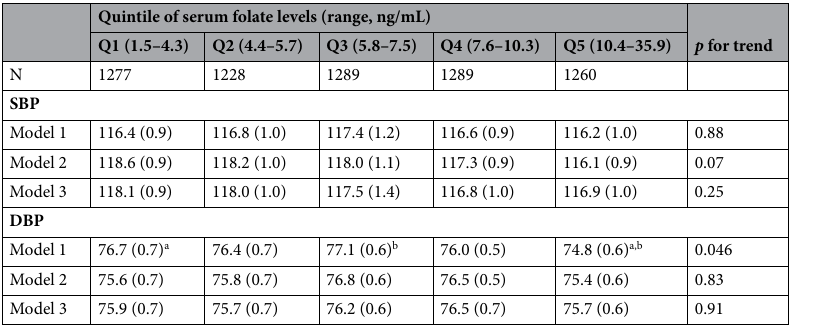
Table 2. Least square means (SE) of SBP and DBP according to quintiles of serum folate levels. Model 1: not adjusted; model 2: adjusted for age and sex; model 3: adjusted for age, sex, education level, household income, occupation, marital status, cigarette smoking, high-risk drinking, strength exercise, obesity, diabetes mellitus, family history of hypertension, energy intake, and sodium intake. Mean in a row with common superscript indicates significant difference, p <